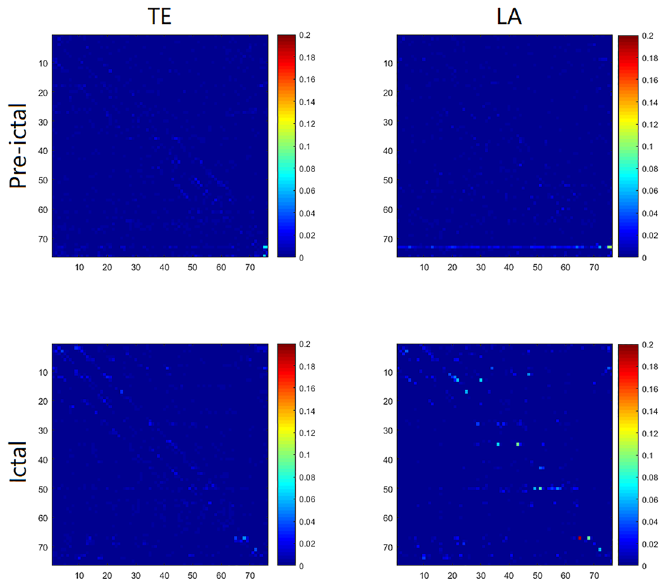
Fig 14. Results for an epileptic EEG recording. Matrices of causalities reflect before (top) and during (down) the clinical onset of a seizure from an epileptic patient, the results are respectively averaged from 8 recordings. Contacts 1 to 64 belong to a cortical electrode grid, and contacts 65 to 76 to two depth electrode strips. The values are computed by traditional non-uniform transfer entropy (TE) and low-dimensional approximation approach (LA). The directions of causal influence are from row to column. The brighter colors correspond to more significant values.